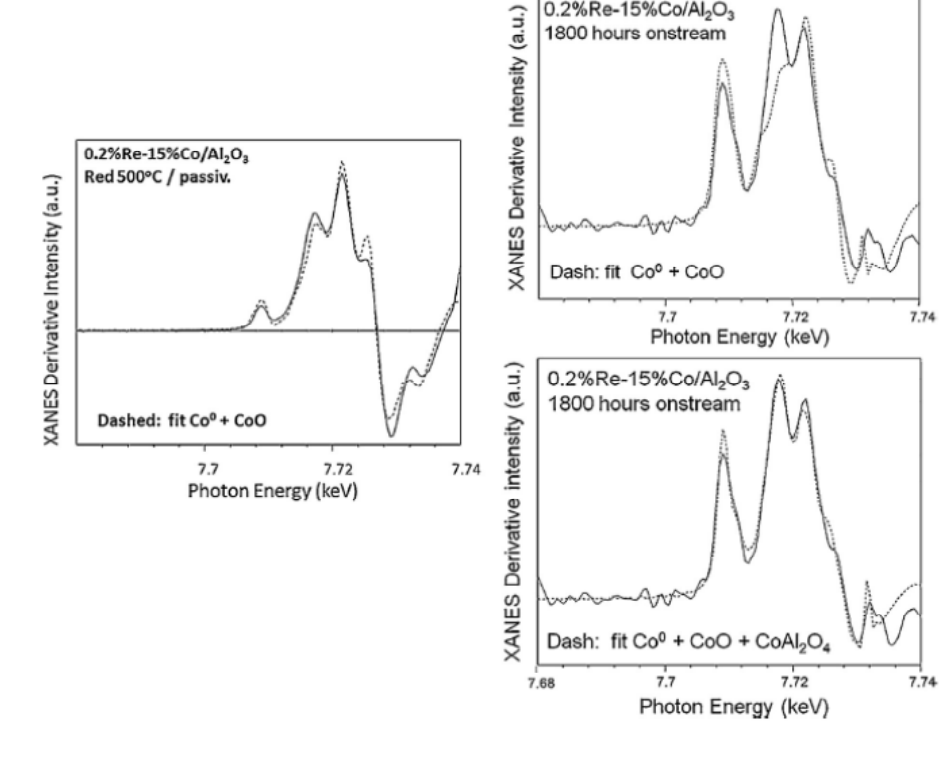
O . Adapted with permission 2 4